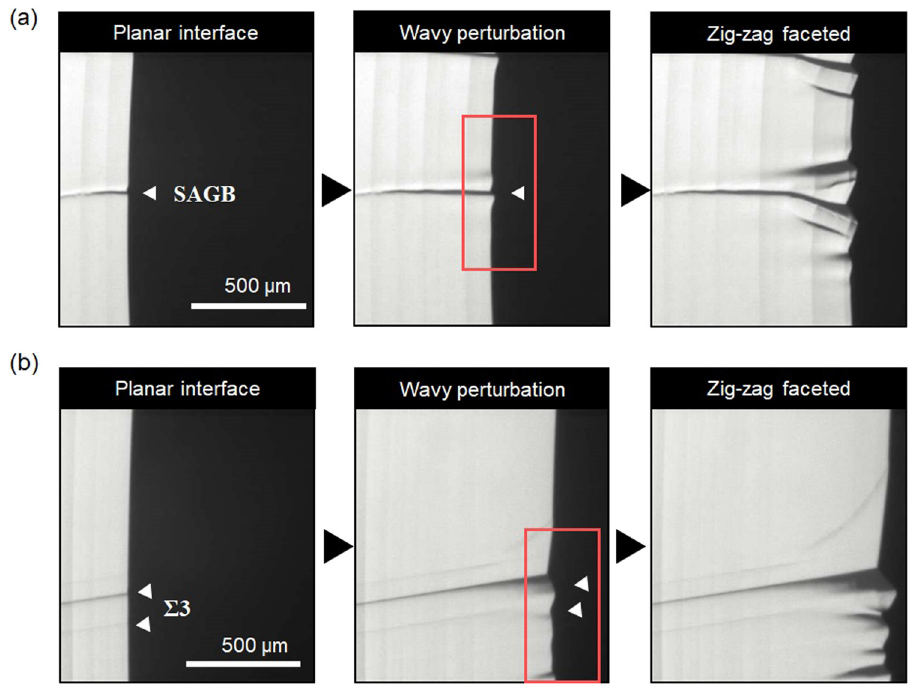
Figure 9: In situ observations of interface instability for Si crystals containing grain boundaries [ 97 ] : ( a ) crystal with a small - angle grain boundary and ( b ) crystal with Σ 3 twin boundaries. In both cases, the interface instability was initiated at the grain boundary position.